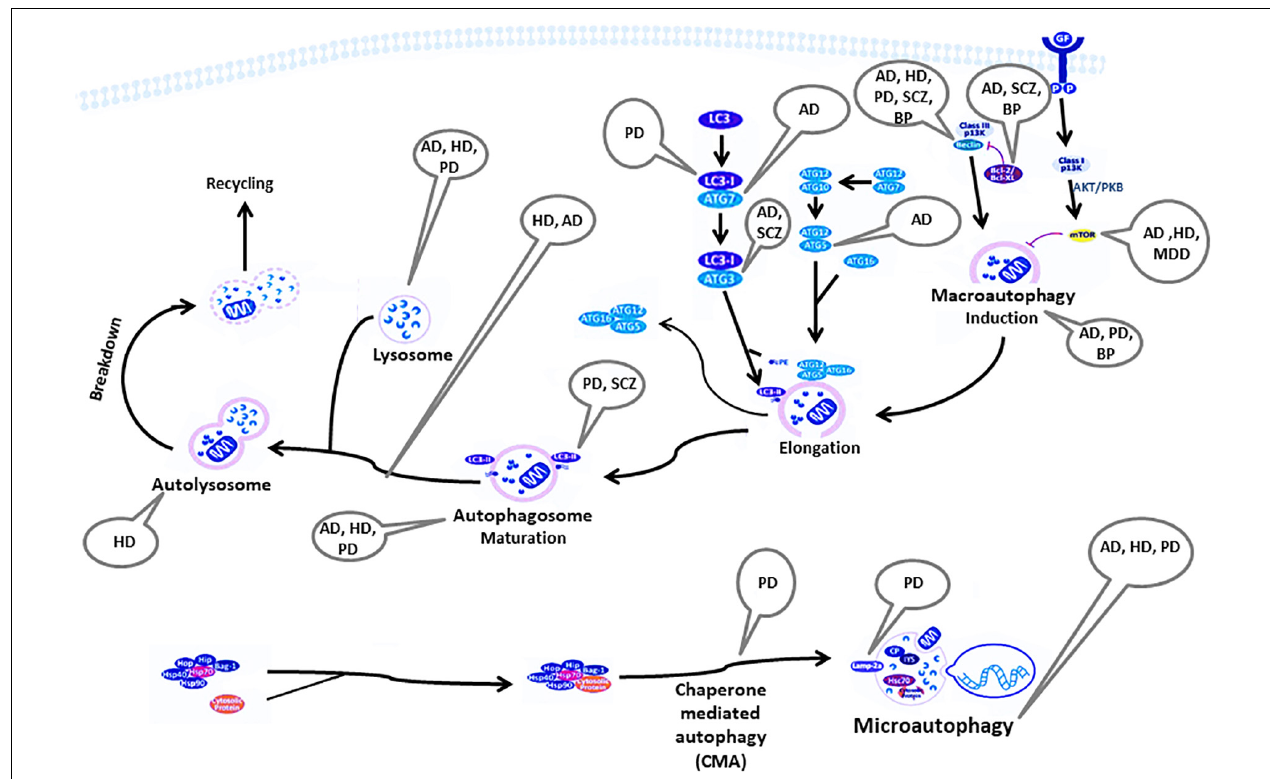
FIGURE 1 | Components of the autophagy pathway reported to be deviated in neuropsychiatric disorders. AD, Alzheimer’s disease; AKT/PKB, RAC-alpha serine/threonine-protein kinase/protein kinase B; ATG, autophagy-related genes; Bag, Bcl-2 associated athanogenes; Bcl-2, B-cell lymphoma 2; BP, bipolar disorder; CP, ceruloplasmin; GF, growth factor; HD, Huntington’s disease; Hip, Hsp70-interacting protein; Hop, Hsp70-Hsp90 organizing protein; HSP, heat shock protein; IP 3 , inositol 1,4,5-trisphosphate; Lamp2a, lysosome-associated membrane protein-2; LC3, light chain 3; MDD, major depressive disorder; mTOR, mammalian target of rapamycin; PD, Parkinson’s disease; PE, phosphatidylethanolamine; SCZ,